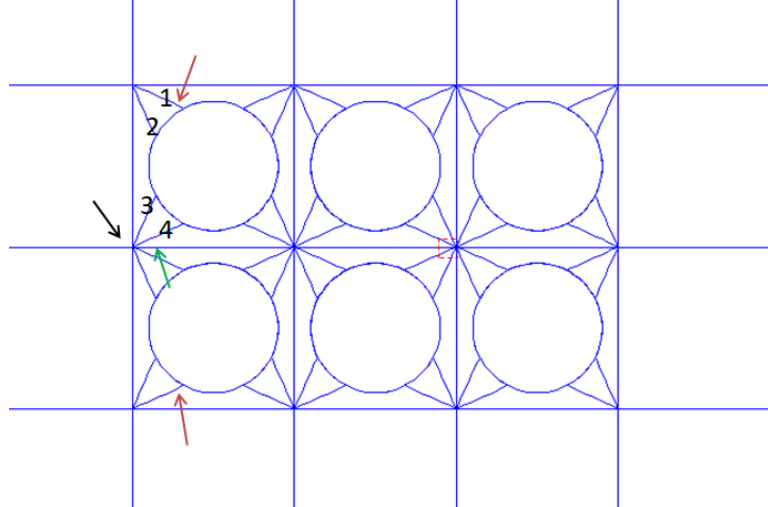
Figure 8. Locations of the maximum mooring force (black: on main ropes, red: on bridle ropes, green: on frame ropes).